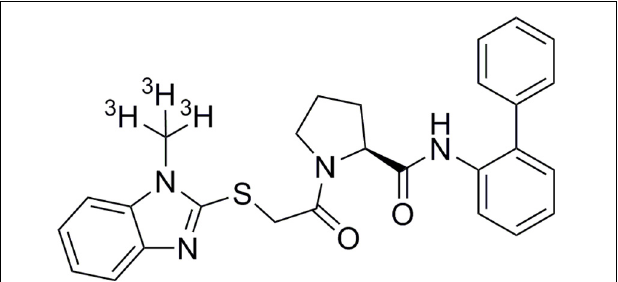
FIGURE 1 | Chemical structure of BBAC ((S)-N-([1,1 (cid:2) -biphenyl]-2-yl)-1- (2-((1-methyl-1H-benzo[d]imidazol-2-yl)thio)acetyl)pyrrolidine-2-